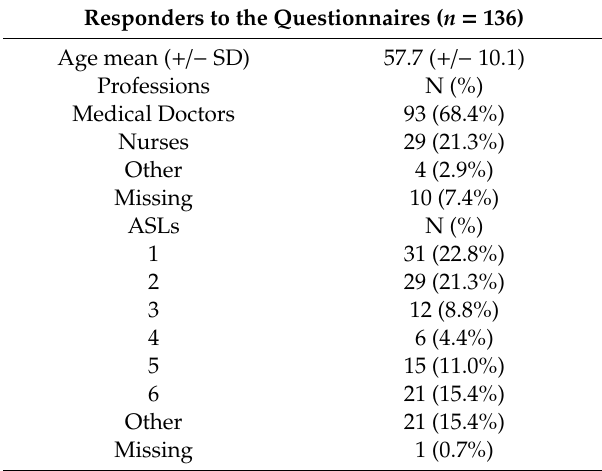
Table 2. Demographic characteristics of the respondents to the